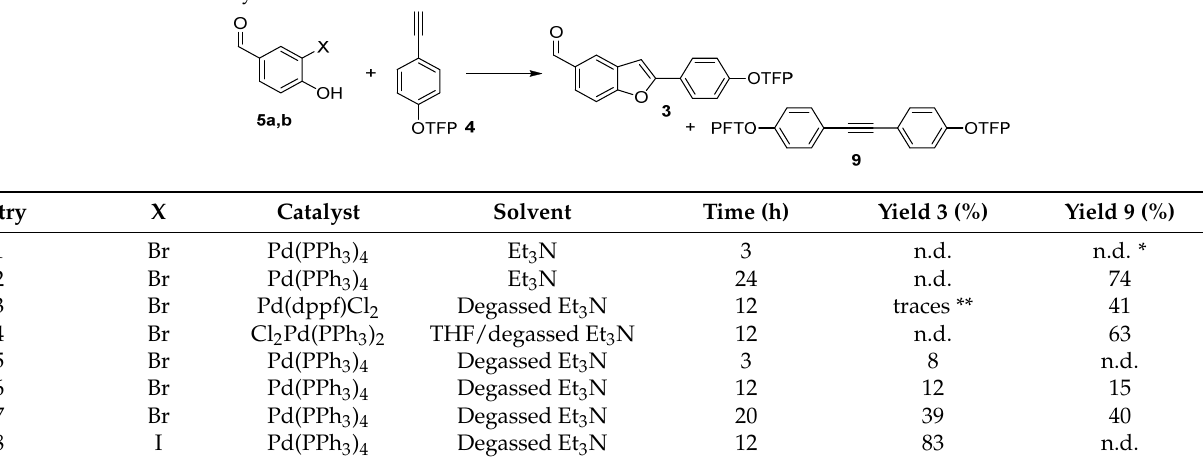
Table 1. Investigation of the reaction conditions of the one-pot Sonogashira coupling–intramolecular cyclization reaction.